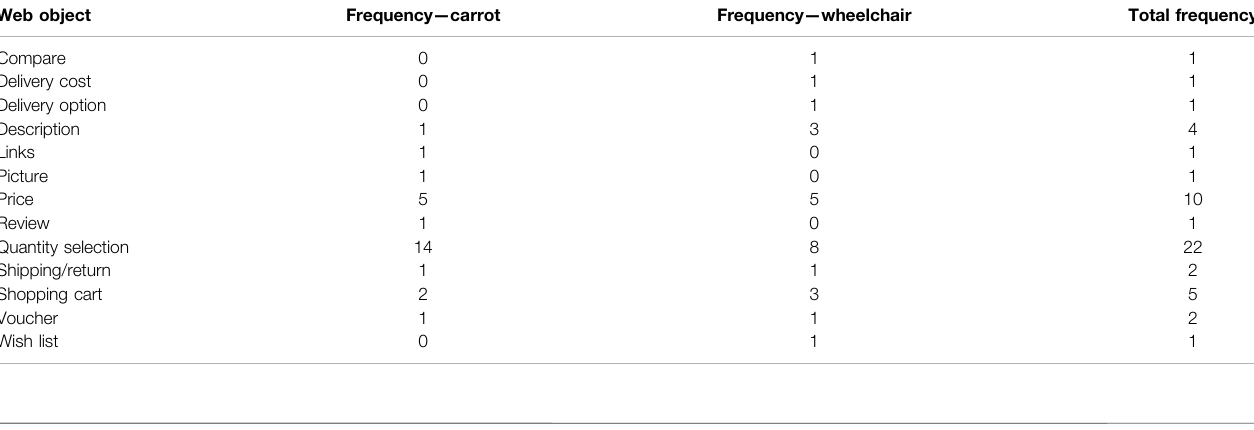
TABLE 5 | Frequency of the web objects placed within two grid squares of the “ add to cart ” button. Web object